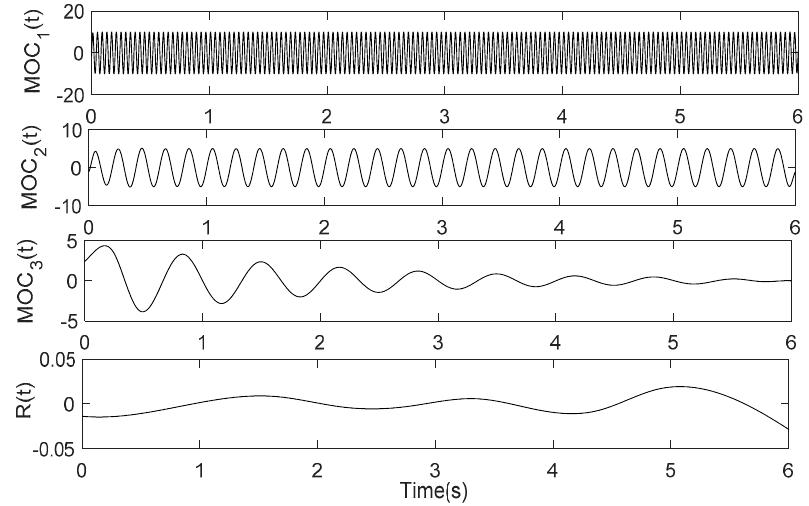
Figure 9. Rational spline based-LOD (RS-LOD) results of the simulation signal x ( t ) ( p = 5).